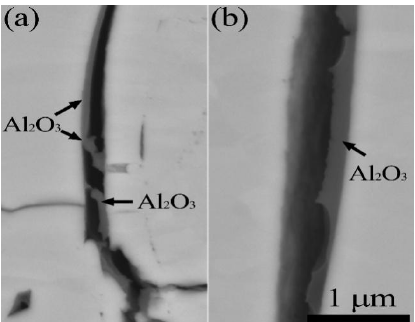
Fig. 50 Cross-sectional SEM images showing alumina distribution in a regular APS TBC whose pore characteristics are tailored via alumina sol impregnation technique: (a) Alumina reduces pore width and forms horizontal connecting arrays and (b) alumina increases pore